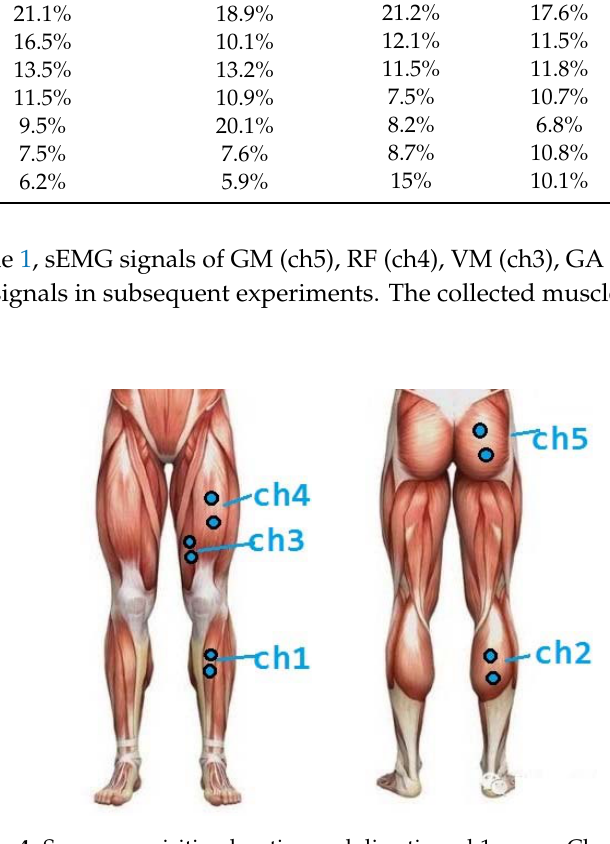
Figure 4. Sensor acquisition location and direction, ch1 means Channel 1.